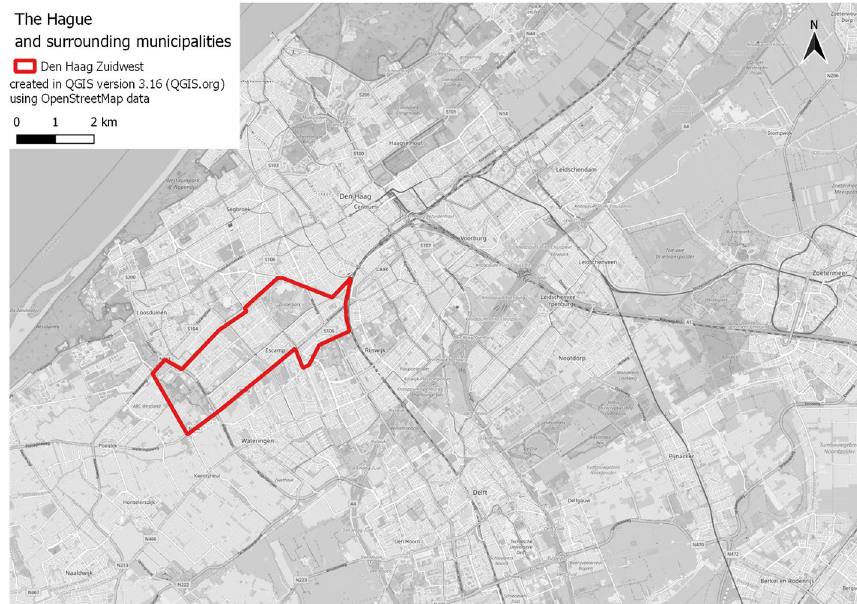
Figure 2. Area of interest: Southwest area of Hague city (Dutch: Zuidwest Den Haag).